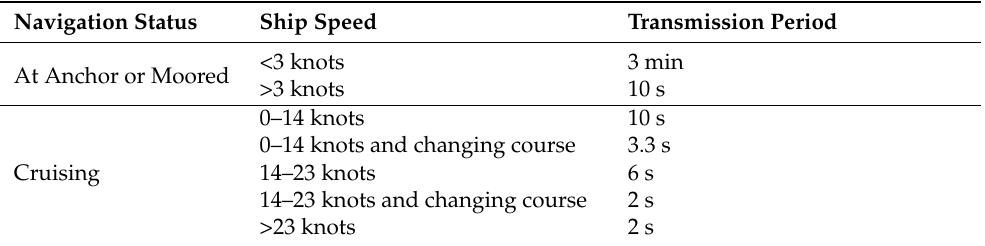
Table 2. Transmission frequency of AIS messages in relation to dynamic